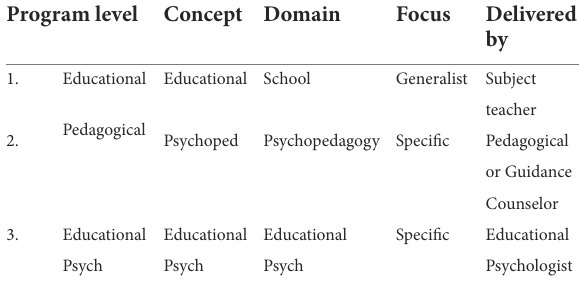
TABLE 1 Categorization of intervention